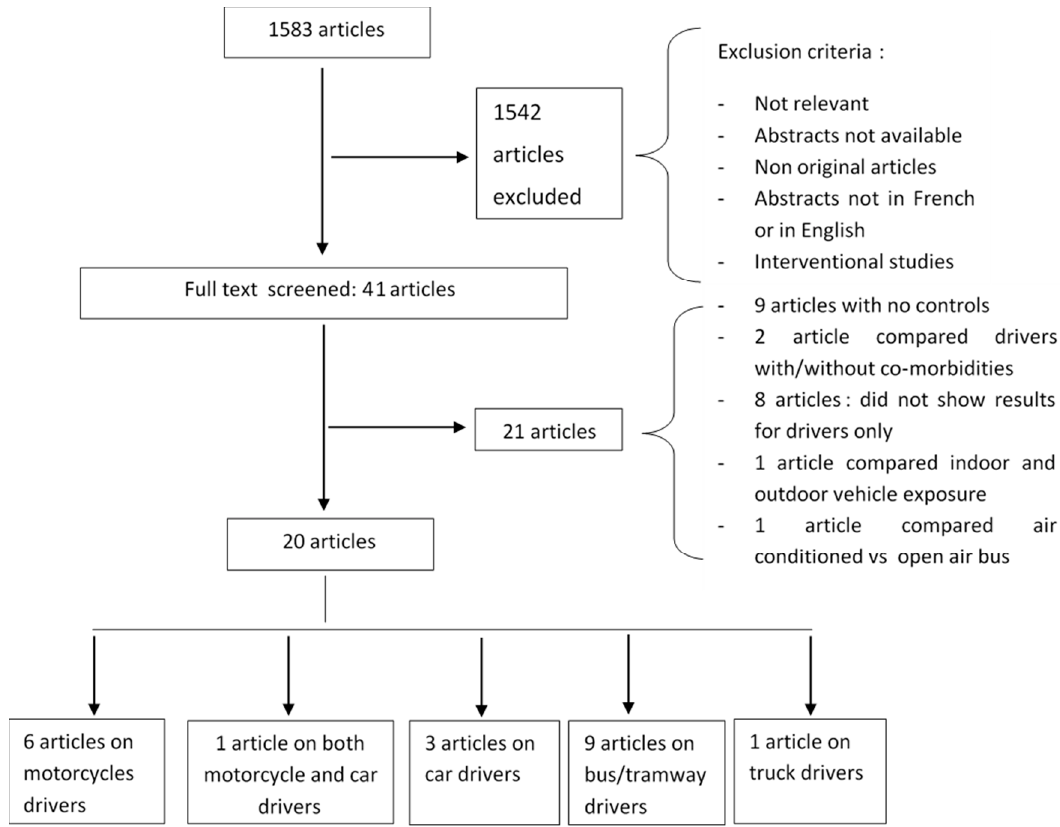
Figure 1. Preferred reporting items for systematic reviews and meta-analyses (PRISMA) flow diagram.